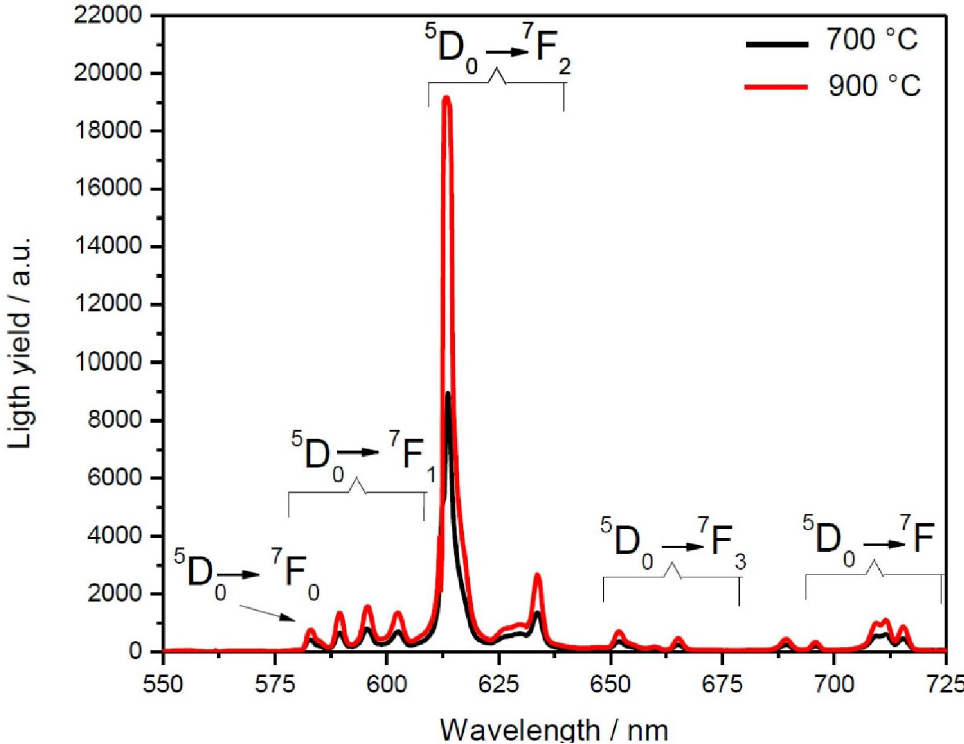
Figure 6. Emission spectra of Lu 700 and 900 °C under X-ray